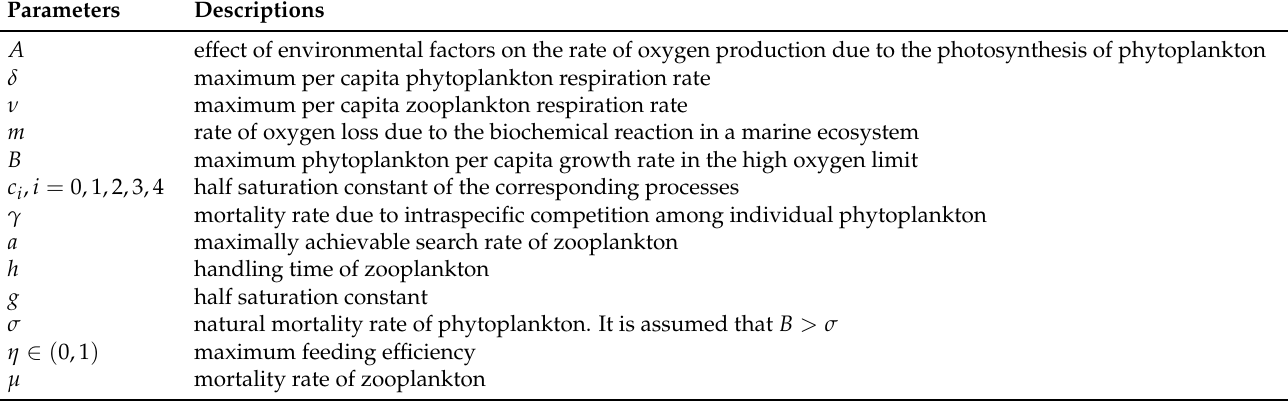
Table 1. Description of biologically meaningful parameters.